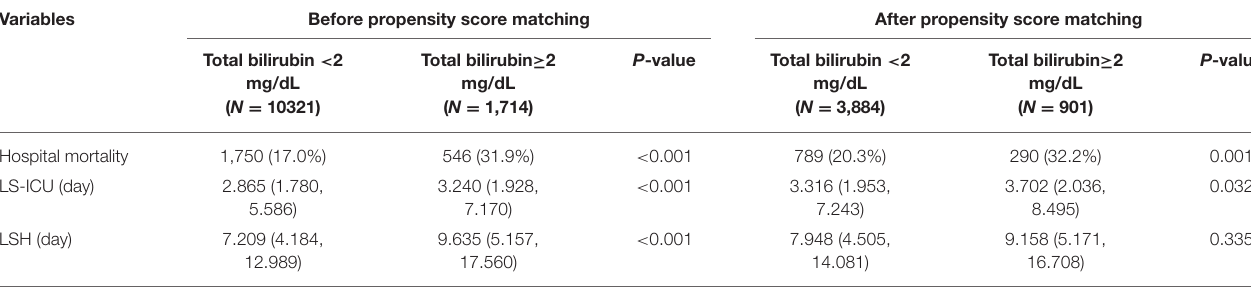
TABLE 2 | Outcomes of critically ill patients before and after propensity score matching. Variables